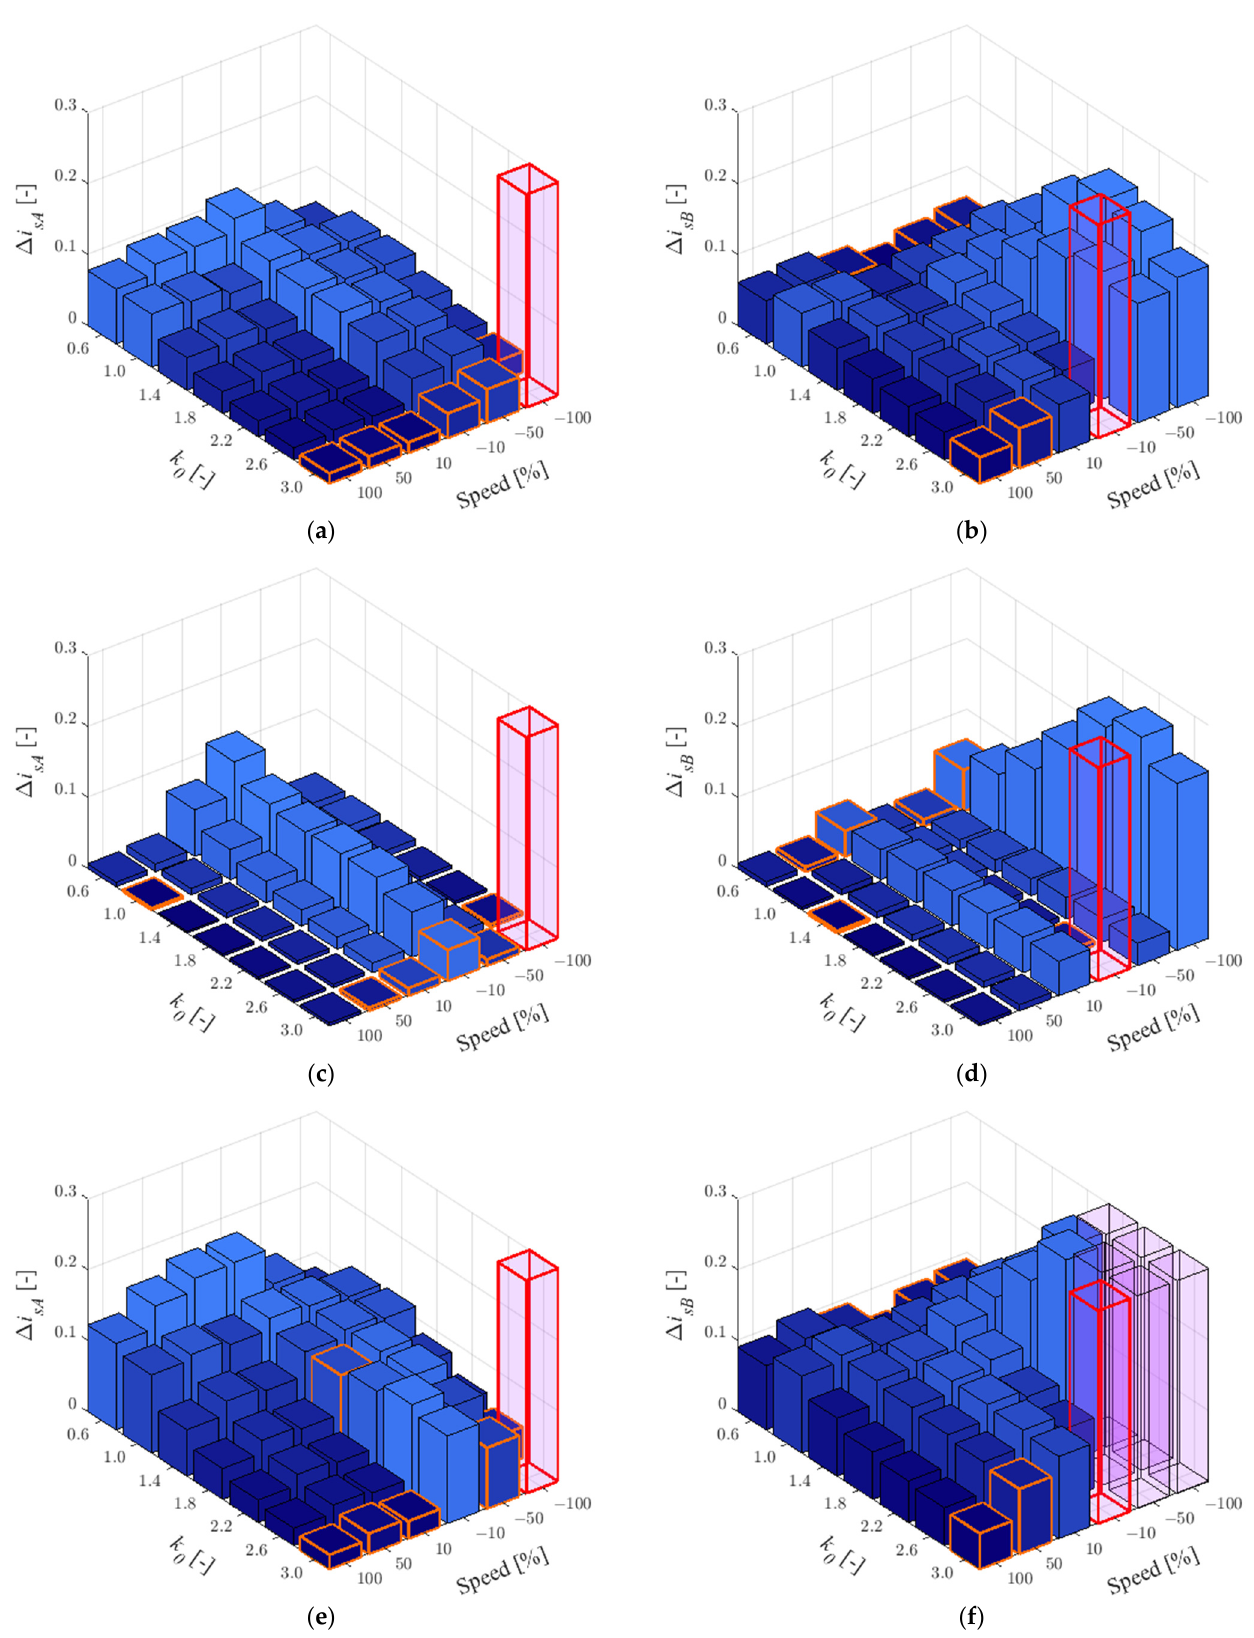
Figure 5. RMSE values for stator currents in phase A ( a , c , e ) and B ( b , d , f ) for r rIM = 1.5 r